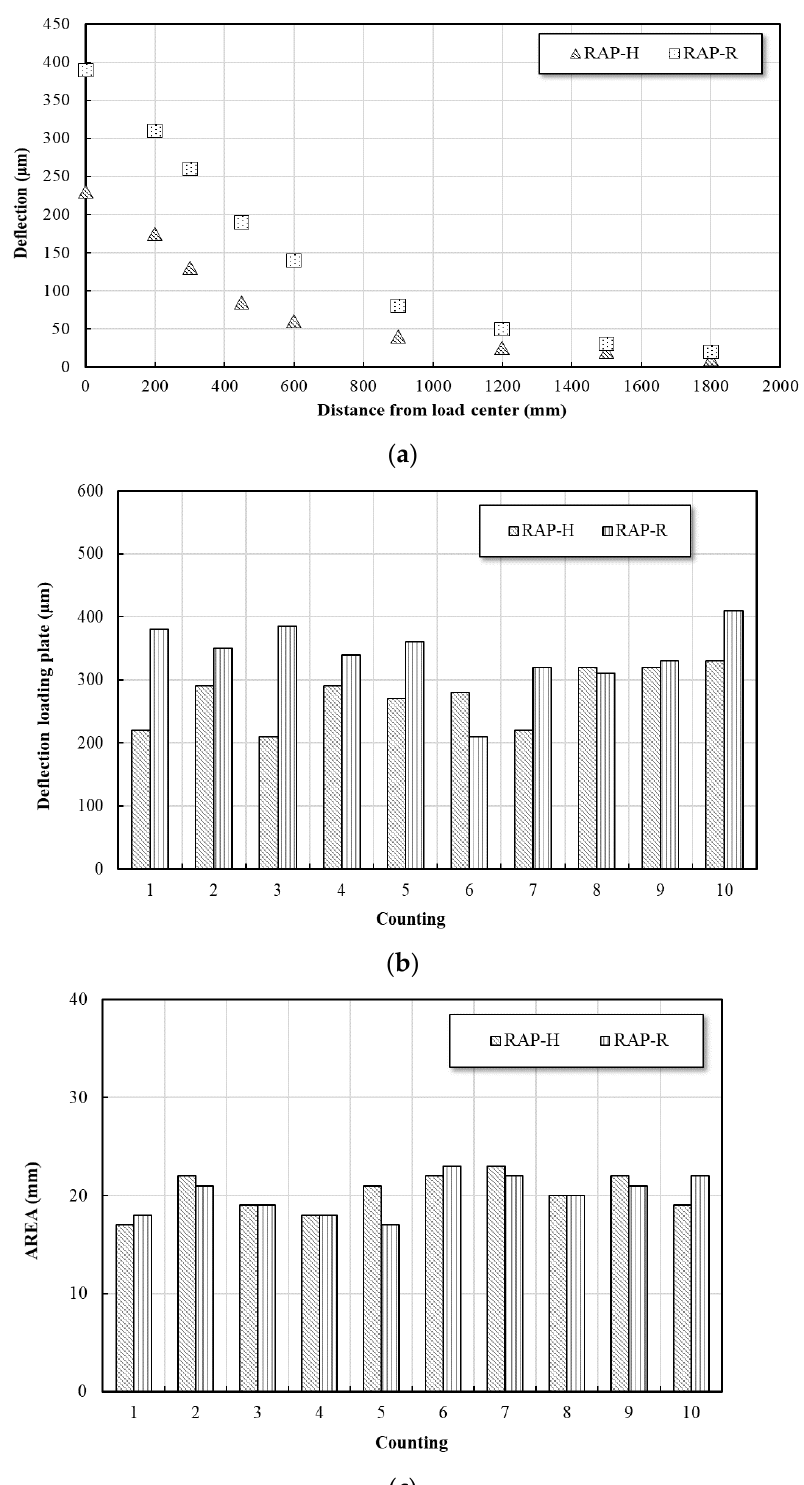
Figure 15. FWD method analysis, showing: ( a ) deflection data, ( b ) Do, and ( c ) AREA basin charac- teristics.